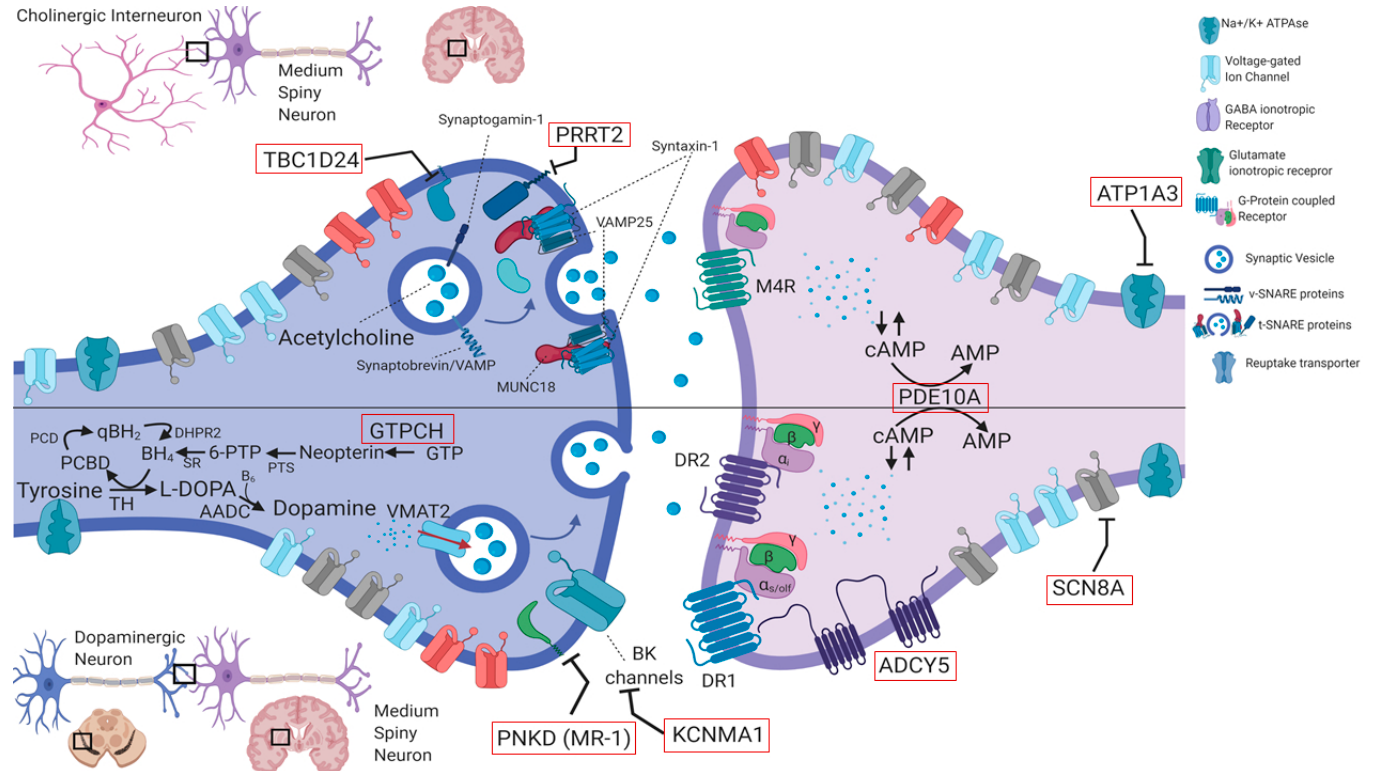
Figure 2. Schematic representation of synaptic neurotransmission mechanisms a ff ected in PMDs in basal ganglia circuits. For simplicity, two hypothetical striatal synapses are shown: The synapse between a cholinergic interneuron and a medium spiny neuron ( top ), and the synapse between a dopaminergic neuron from the substantia nigra pars compacta and a striatal medium spiny neuron ( bottom ). Both these types of synapses are critical for control of volitional movements in humans. Red rectangles indicate genes involved in PMDs. Calcium channels are depicted in red, sodium channels in grey, potassium channels in blue. PMD: Paroxysmal movement disorders, GTPCH: GTP cyclohydrolase I, PTS: 6-Pyruvoyl Tetrahydrobiopterin Synthase, SR: sepiapterin reductase, BH4: Tetrahydrobiopterin; PCBD: pterin-4 α -carbinolamine, PCD: pterin-4 α -carbinolamine dehydratase, qBH2: quinonoid dihydrobiopterin; DHPR2: dihydropteridine reductase; TH: Tyrosine Hydroxylase; AADC: Aromatic l-amino acid decarboxylase, B6: pyridoxal phosphate (active form of vitamin B6); VMAT2: Vesicular monoamine transporter 2 (encoded by the SLC18A2 gene), (c)AMP: (cyclic) adenosine monophosphate. DR1: dopamine receptor type 1; Dopamine receptor type 2.